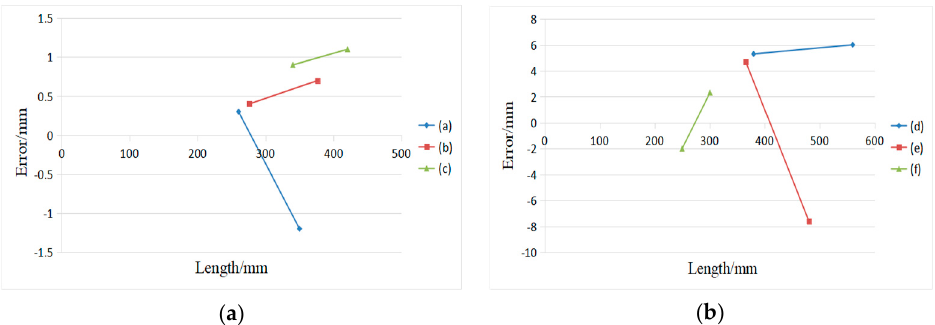
Figure 24. Measurement results; ( a ) Errors between the actual length and the measured result affected by optical quality of the box surface; and, ( b ) Errors between the actual length and the measured result tested on boxes with surface variation.